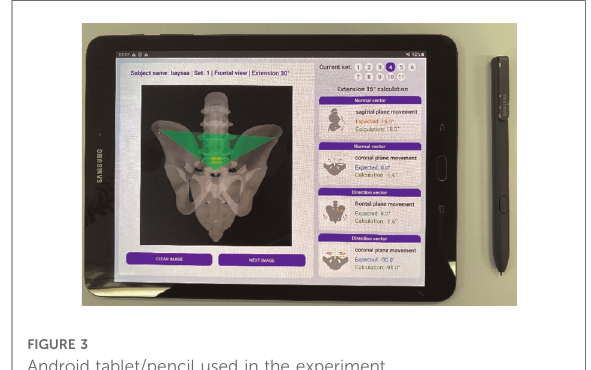
FIGURE 3 Android tablet/pencil used in the experiment.